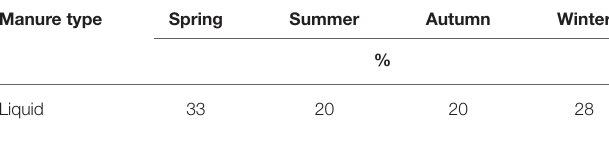
TABLE 2 | Seasonal distribution of livestock slurry